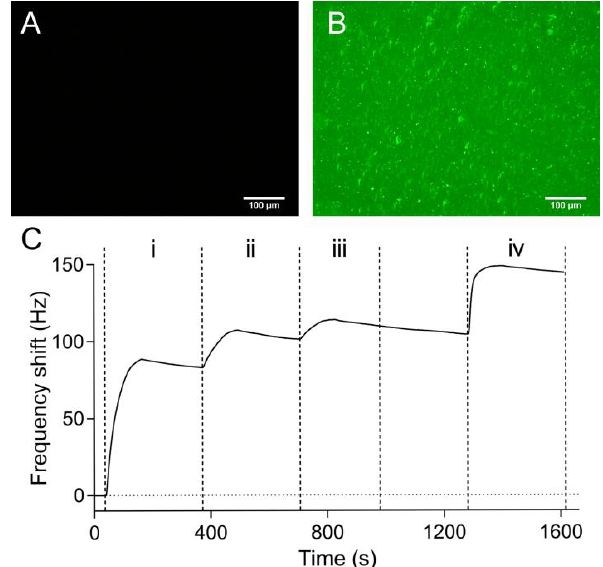
Figure 5. Fluorescent images of the PDA-coated sensor chip before ( A ) and after ( B ) the incubation with avidin-FITC (fluorescein isothiocyanate) ( C ) The subsequent biotinylated Con A capturing and mannan test on the avidin-FITC surface were performed by three injections of 100 µ g/mL biotinylated Con A (i–iii) and an injection of 100 µ g/mL mannan